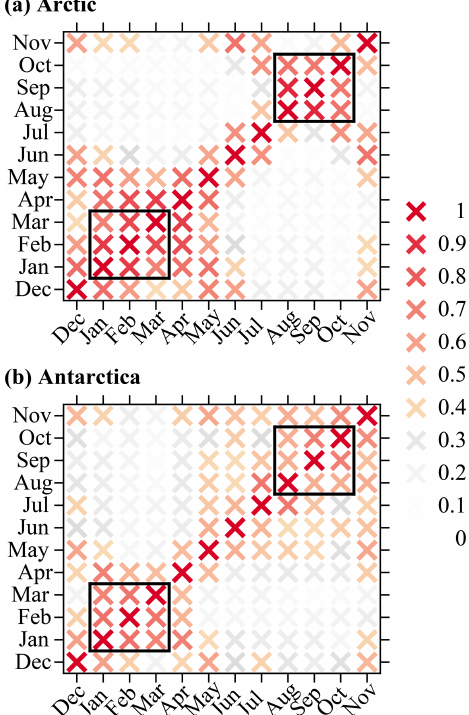
Figure 2. Maximum correlation coefficient across the monthly clus- ters in (a) the Arctic and (b) Antarctica in OSISAF. Two 3-month periods (seasons) stand out with the largest coefficients: January through March (JFM) and August through October (ASO). Values smaller than 1 /e ( ∼ 0 . 37) are considered statistically nonsignificant and plotted in gray. Similar results are obtained using NSIDC and HadISST SIC (and therefore are not